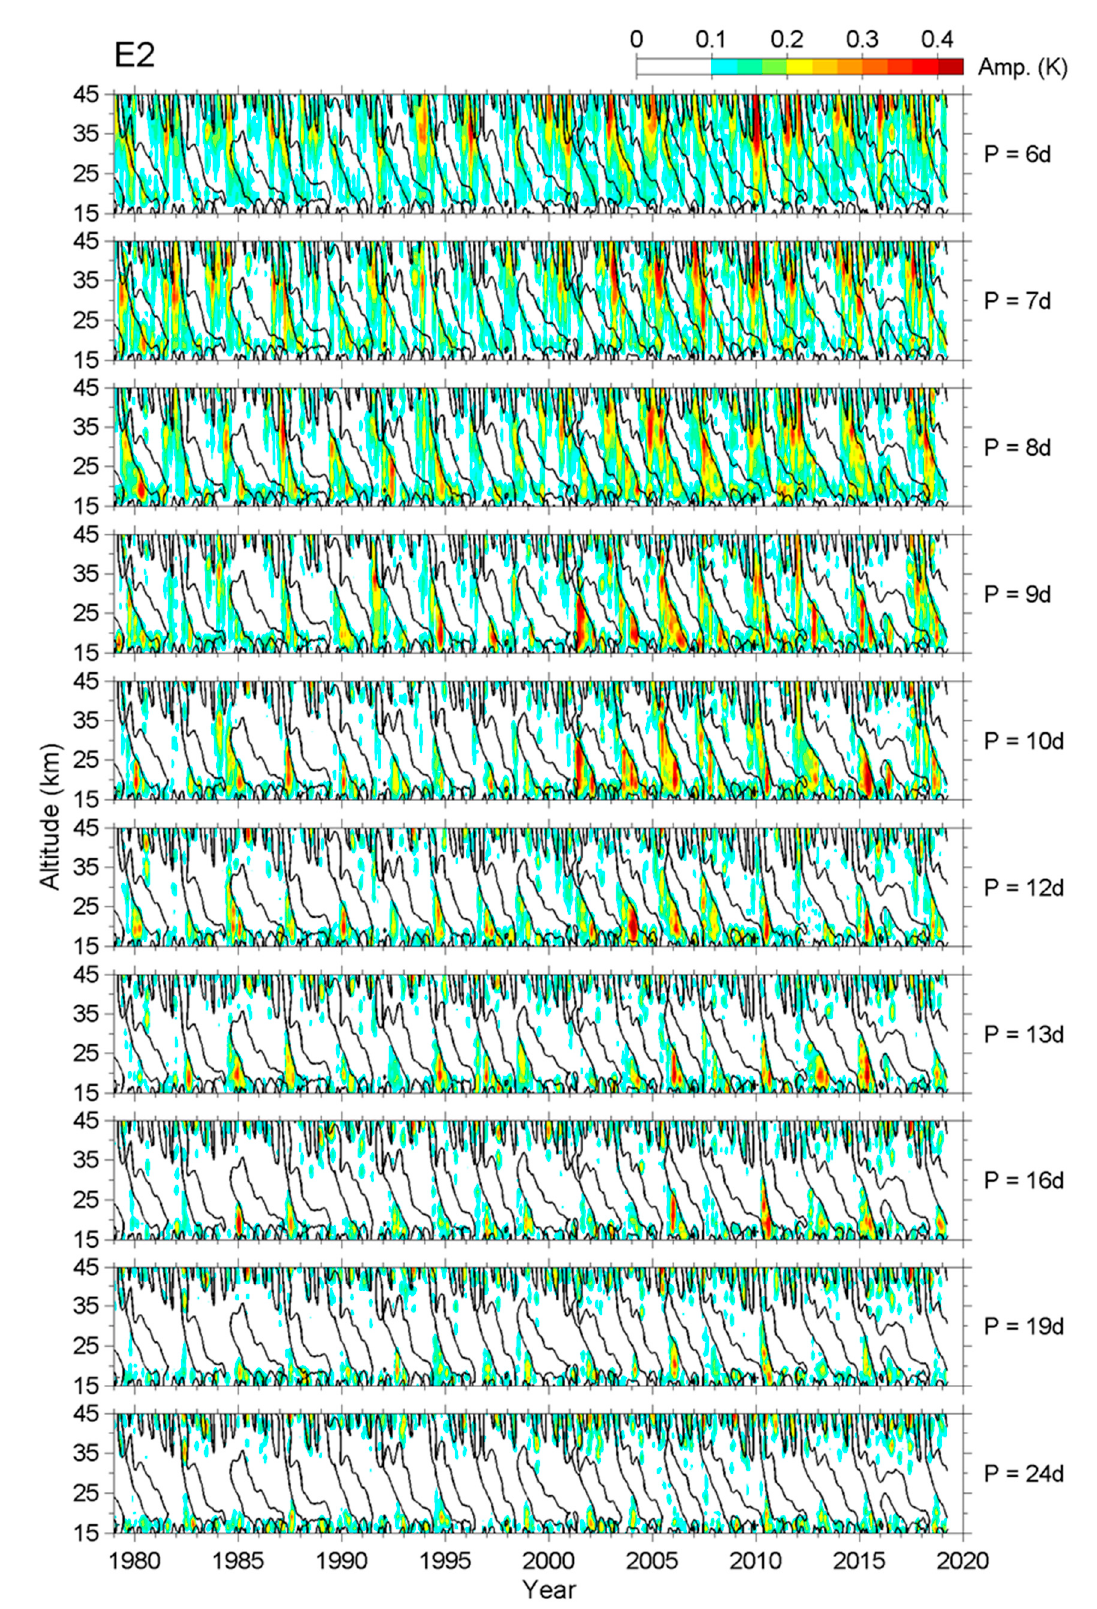
Figure 5. Same as in Figure 3, but showing the amplitudes of E2 waves with a different color axis scaling.